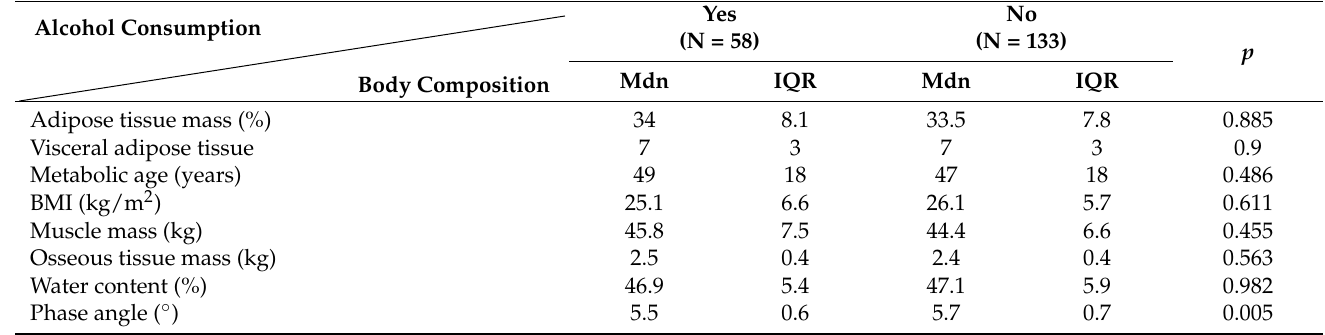
Table 9. Body composition analysis in relation to alcohol consumption in the studied women.